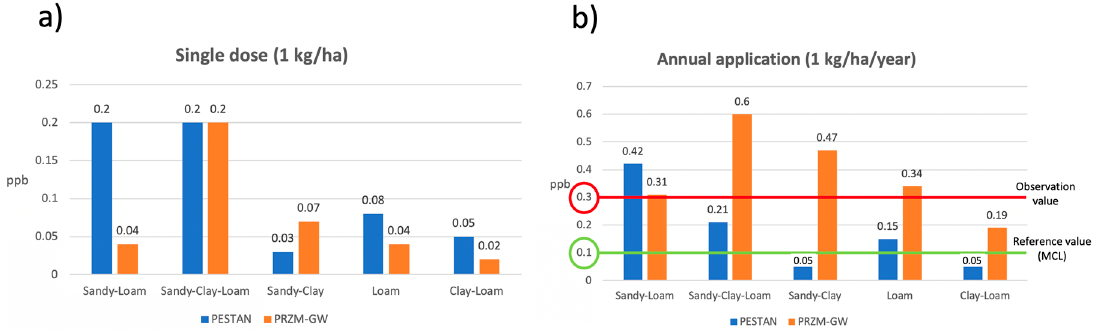
Figure 9. Maximum terbuthylazine concentration values. ( a ) Single dose (1 kg / ha). ( b ) Annual application (1 kg / ha / year).